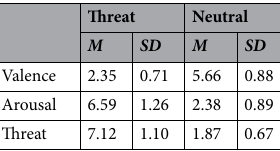
FMRI data acquisition and analysis. Structural and functional data were obtained using a 1.5 Tesla magnetic resonance scanner (“Magnetom Vision plus”, Siemens, Medical Systems, Erlangen, Germany) with a head coil gradient set. During the tasks, blood oxygenation level-dependent contrast functional images were acquired using a T2*-weighted echo-planar pulse sequence (TR = 2980 ms, TE = 50 ms, flip angle = 90°, field of view = 192 mm, matrix size = 64 × 64). For each participant, two scan runs of 184 volumes each during which either the indirect or direct task were realized were conducted. Each volume comprised 30 interleaved axial slices (thickness = 3 mm, gap = 1 mm, in-plane resolution = 3 × 3 mm) orientated in an approximately 30° tilted angle from the anterior–posterior commissure plane in order to reduce susceptibility artifacts in inferior parts of anterior brain areas 48 . The first four volumes of each functional run were discarded from analysis to ensure that steady-state tissue magnetization was reached. For anatomical reference, a whole brain high-resolution T1-weighted volume was recorded for each participant during the same experimental session using a 3D spoiled gradient echo pulse sequence. Functional MRI-data preprocessing and analyses were conducted by using the software package BrainVoyager QX (Version 1.8.6; Brain Innovation, Maastricht, The Netherlands). Primarily, all volumes were realigned to the first volume in order to minimize artifacts due to head movements and a slice time correction was conducted. Further data preprocessing comprised spatial (8 mm full-width half-maximum isotropic Gaussian kernel) as well as temporal smoothing (high pass filter: 8 cycles per run, low pass filter: 2.8 s). The anatomical and functional